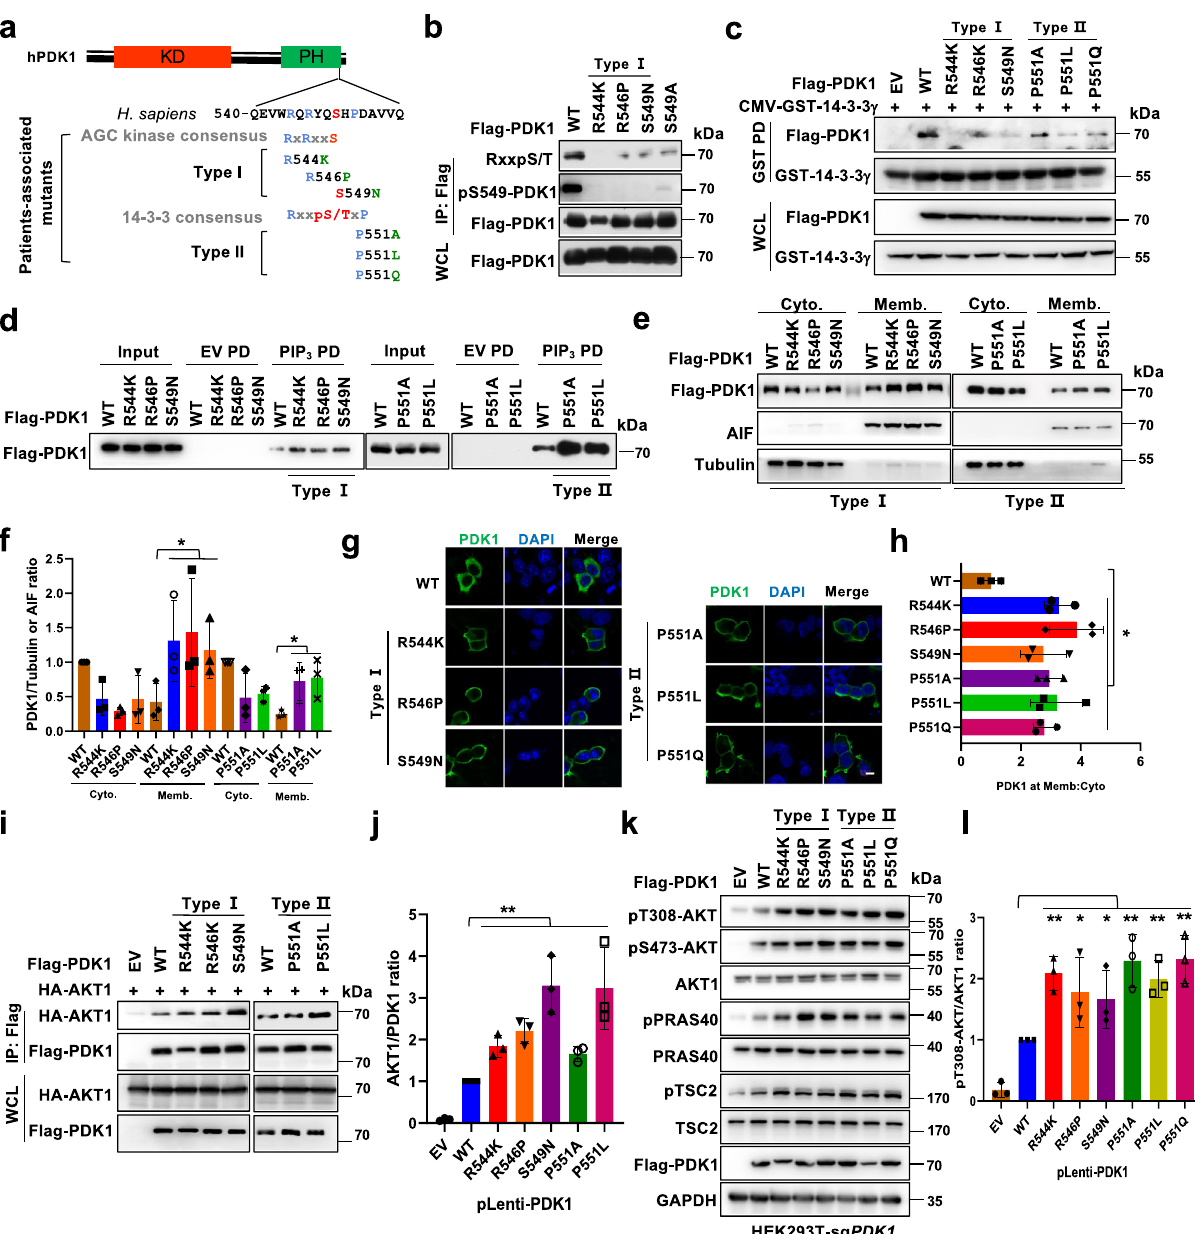
Fig. 5 Patients-associated mutations of PDK1 confer to PDK1 membrane location and AKT kinase activation. a A schematic presentation of the patients- associated PDK1 mutations occurred around S6K1-mediated PDK1 phosphorylation or 14-3-3 γ binding region. b IB analysis of WCL and IP products derived from 293 T cells transfected with the indicated constructs. c IB analysis of WCL and GST-pull-down derived from 293 T cells transfected with GST-14-3-3 γ and the indicated constructs. d IB analysis of PIP 3 pull-down products and WCL derived from 293 T cells transfected with Flag-PDK1(WT, R544K, R546P, S549N, P551A, P551L). e IB analysis of cell fractionations separated from 293 T cells transfected with the indicated constructs. f PDK1/Tubulin or AIF ratio in e were calculated, (mean ± SD, n = 3), * P < 0.05. g Representative immuno fl uorescence images of 293 T cells transfected with the indicated constructs, scale bar, 10 μ m. h Mean PDK1 fl uorescence intensity at plasma membrane relative cytosol was determined, data represent mean ± SD, P = 0.022, 0.036, 0.011, 0.035, 0.026, 0.030. Greater than 60 cells were analyzed from 3 independent experiments. i IB analysis of WCL and IP products derived from 293 T cells transfected with HA-AKT1 and the indicated construct. j AKT1/PDK1 ratio in i were calculated, (mean ± SD, n = 3), * P < 0.05. k IB analysis of WCL derived from 293T- PDK1 knockout cells transfected with the indicated constructs. l pT308-AKT/AKT1 ratio in k were calculated, (mean ± SD, n = 3), * P < 0.05, ** P < 0.01. Similar results were obtained in n ≥ 3 independent experiments in b , c , d . Statistical signi fi cance was determined by two-tailed Student ’ s t -test in f , h , j , l . * P < 0.05, ** P < 0.01. Source data are provided in Source Data fi les. EV, empty vector. WCL, whole cell lysate. IP, immunoprecipitation. WT, wild type. PD, pulldown. Cyto, cytoplasm. Memb, Antibodies . All antibodies were diluted in TBST buffer with 5% non-fat milk for (5318, 1:1000), anti-phospho-Ser9-GSK3 β antibody (5558, 1:3000), anti-GSK3 β antibody (12456, 1:1000), anti-phospho-FOXO1 (Ser256) antibody (9461, 1:1000), western blot. Anti-AKT Substrate (RxxpS/T) antibody (9614, 1:1000), anti-phospho- anti-Myc antibody (2276, 1:1000), anti-GST antibody (2625, 1:1000), anti-pS6K1 Ser473-AKT antibody (4060, 1:3000), anti-phospho-Thr308-AKT antibody (2965, (Thr389) antibody (9205, 1:1000), anti-S6K1 antibody (2708, 1:1000), anti-S6 anti- 1:1000), anti-AKT total antibody (4691, 1:3000), anti-PDK1 antibody (13037, body (2217, 1:13000) and anti-pS240/244-S6 antibody (5364, 1:3000) were obtained 1:1000), anti-phospho-Ser241-PDK1 antibody (3061, 1:3000), anti-AIF antibody